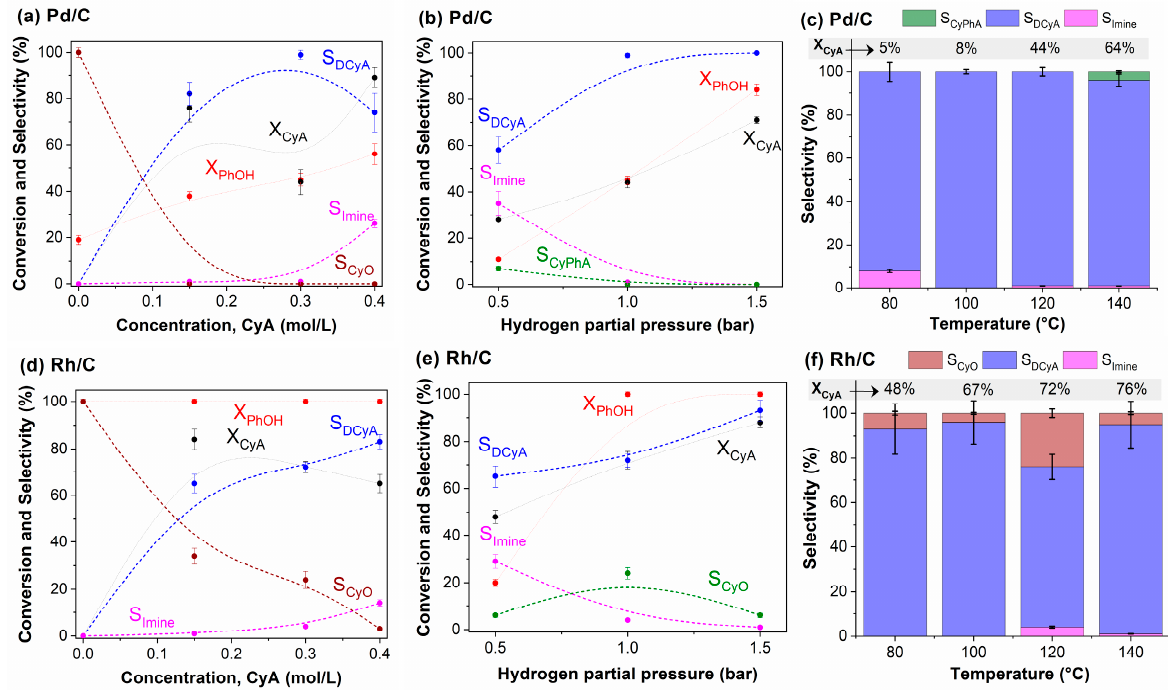
Figure 5. E ff ect of ( a , d ) cyclohexylamine concentration, of ( b , e ) H 2 pressure and ( c , f ) temperature on Pd/C and Rh/C, respectively. The reactions were carried out using H 2 gas (0.5–1.5 bar), He (0.5–1.5 bar), C 0 PhOH = 0.2 mol/L, CyA (0.15–0.4 mol/L), and temperatures between 80 and 140 °C with t R = 6 h.